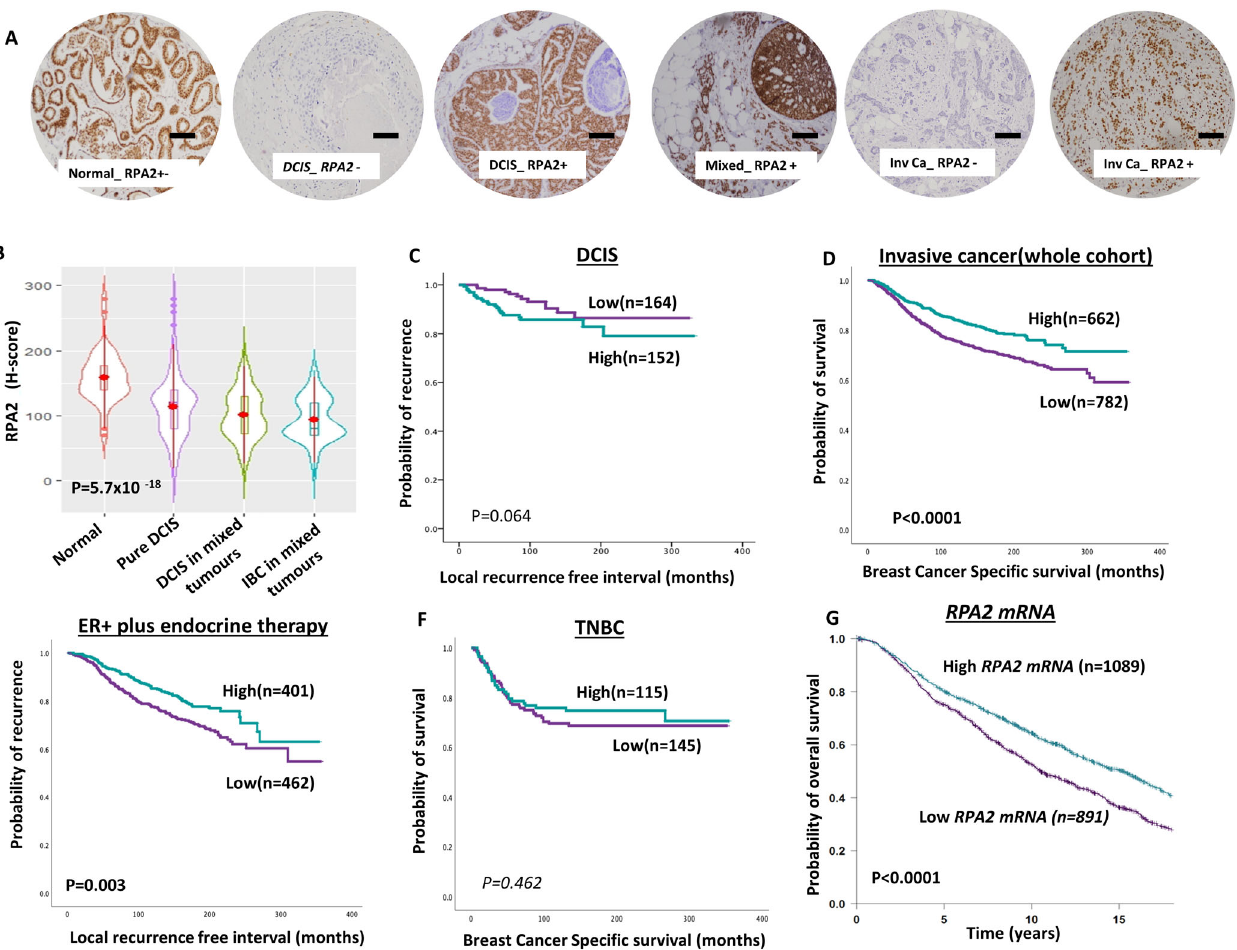
Fig. 2 Clinicopathological studies of RPA2 expression in breast cancers. A Photomicrographs showing immunohistochemical staining of RPA2 in breast cancers (scale bar “ − ” = 100 µM). B Violin plot shows the mean of RPA2 expression in normal, pure DCIS and DCIS mixed tumours [The red dot represents the median, open red bar in the center represents the interquartile range, the thin red line represents the rest of the distribution, except for points that are “ outliers ” . On each side of the red line is a kernel density estimation to show the distribution shape of the data. Wider sections of the violin plot represent a higher probability that members of the population will take on the given value; the skinnier sections represent a lower probability.]. C Kaplan – Meier curve for RPA2 nuclear protein expression and recurrence-free interval (LRFI) in DCIS ( D ) a Kaplan – Meier curve for RPA2 nuclear protein expression and breast cancer-speci fi c survival (BCSS) in the whole cohort. E Kaplan – Meier curve for RPA2 nuclear protein expression and BCSS in ER + cohort with endocrine therapy. F Kaplan – Meier curve for